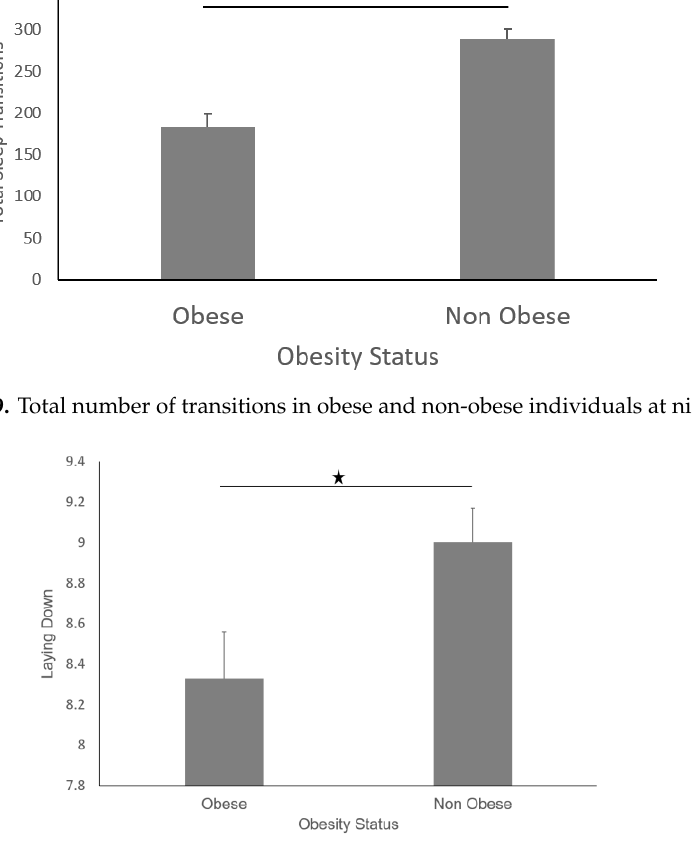
Figure 20. Average hours of laying down for obese and non-obese participants.